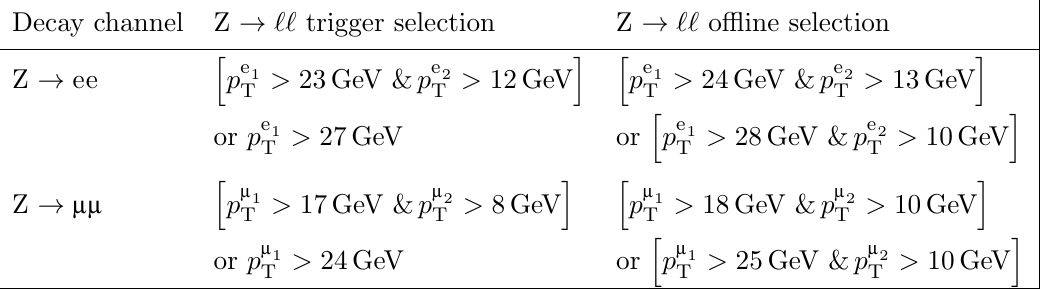
thresholds or single-lepton trig- T leptons T